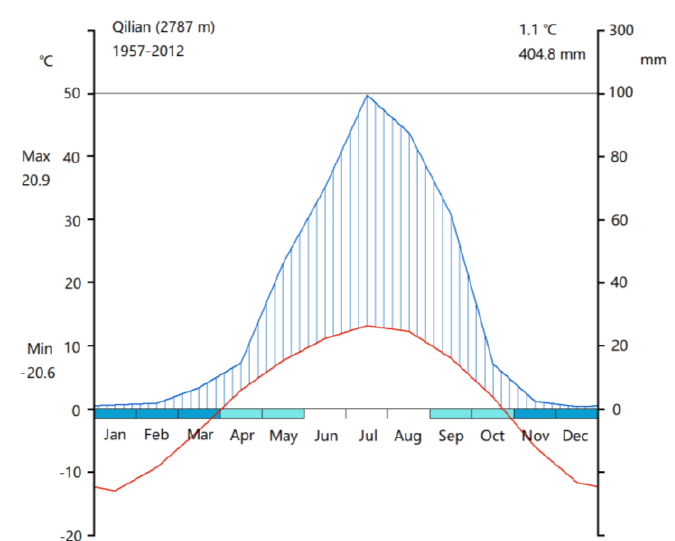
Figure 2. Walter and Lieth climatic diagram for Qilian meteorological station during 1957–2012. Mean monthly precipitation is plotted as the blue line and mean monthly air temperature as the red line. Humid periods are filled by vertical blue lines. The values of mean maximum temperature of the warmest month and mean minimum temperature of the coldest month are shown along the y-axis. Probable frost periods are shown by light blue boxes and definite frost periods are shown by dark blue boxes along the x-axis.